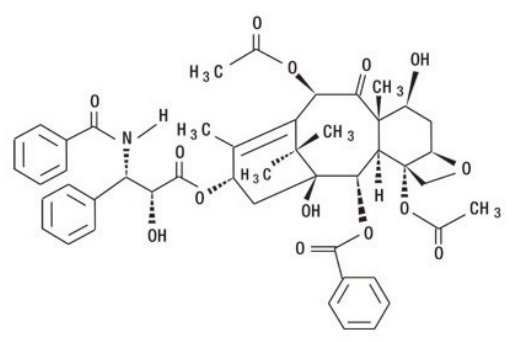
Figure 1. Molecular Structure of Paclitaxel Drug.